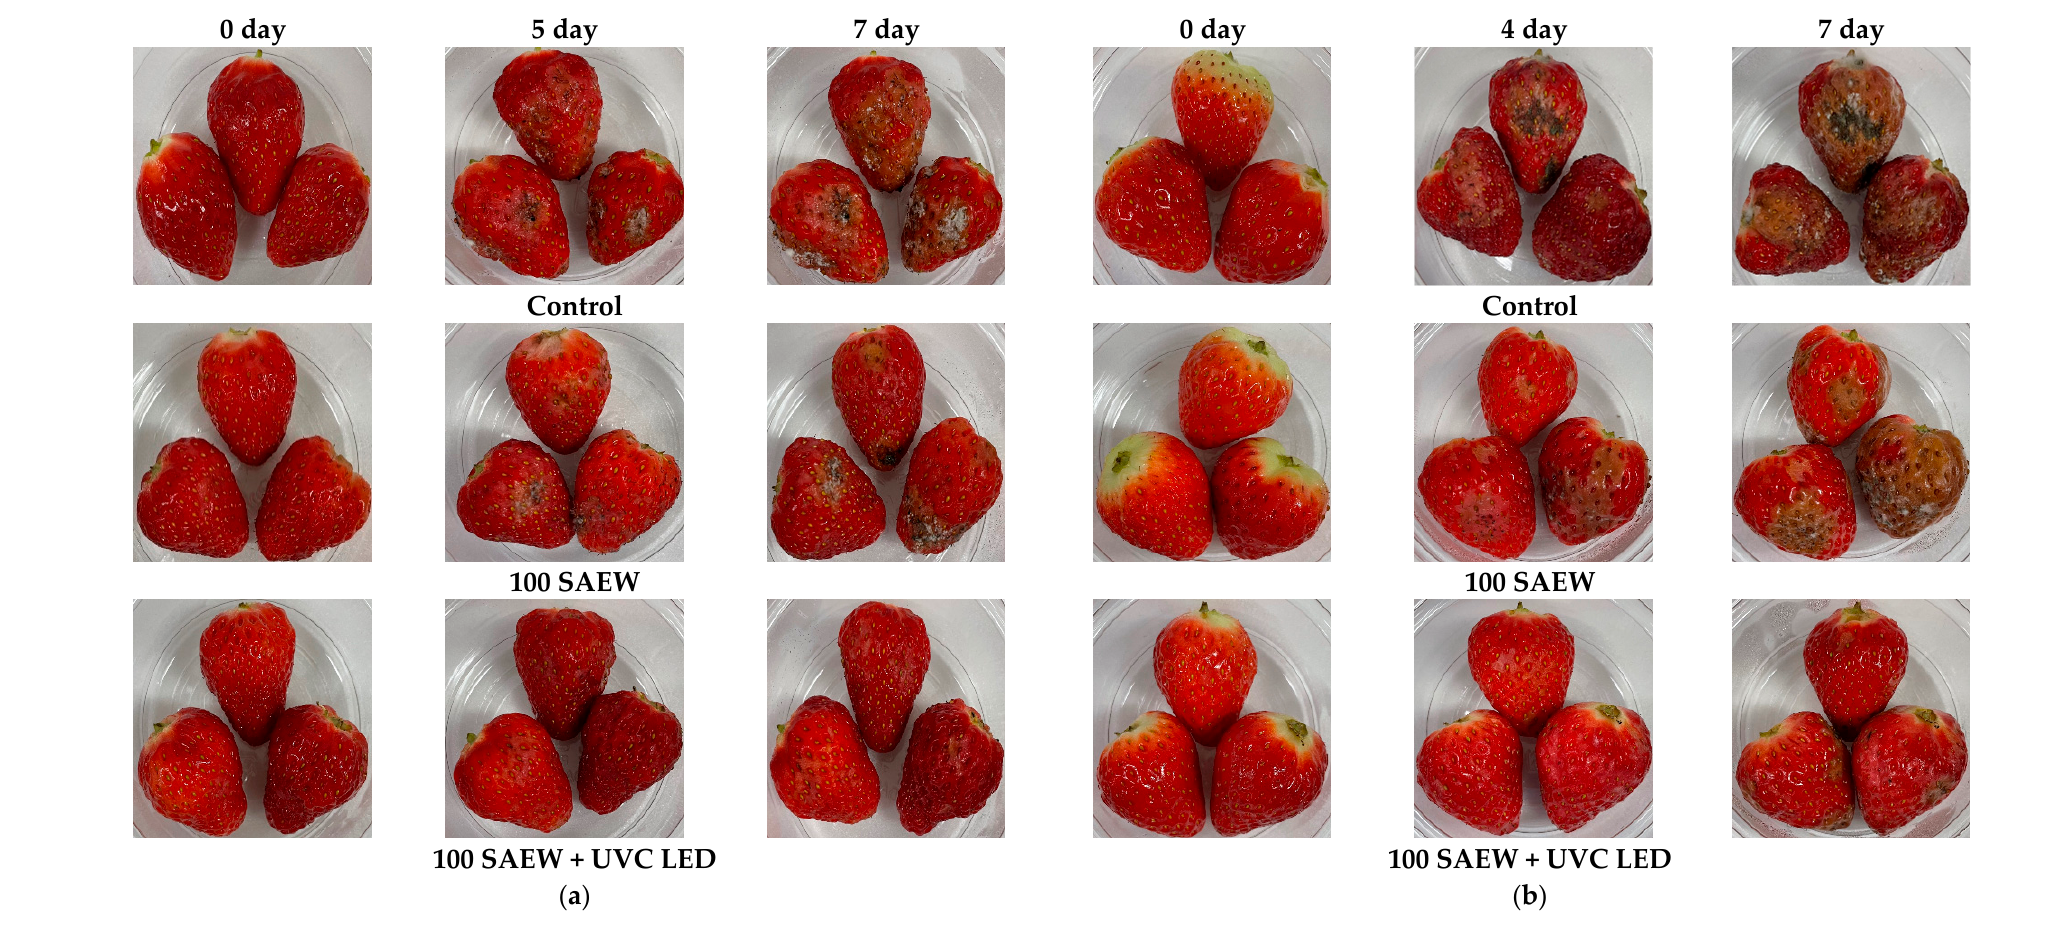
Figure 5. Visual appearance of strawberries stored for 7 days at ( a ) 10 and ( b ) 15 °C. Control, no extra wash with sanitizer; 100 SAEW, aerosolization with 100 ppm SAEW; 100 SAEW + UVC LED, aerosolization with 100 ppm SAEW and UVC LED irradiation (275 nm) for 3 min.